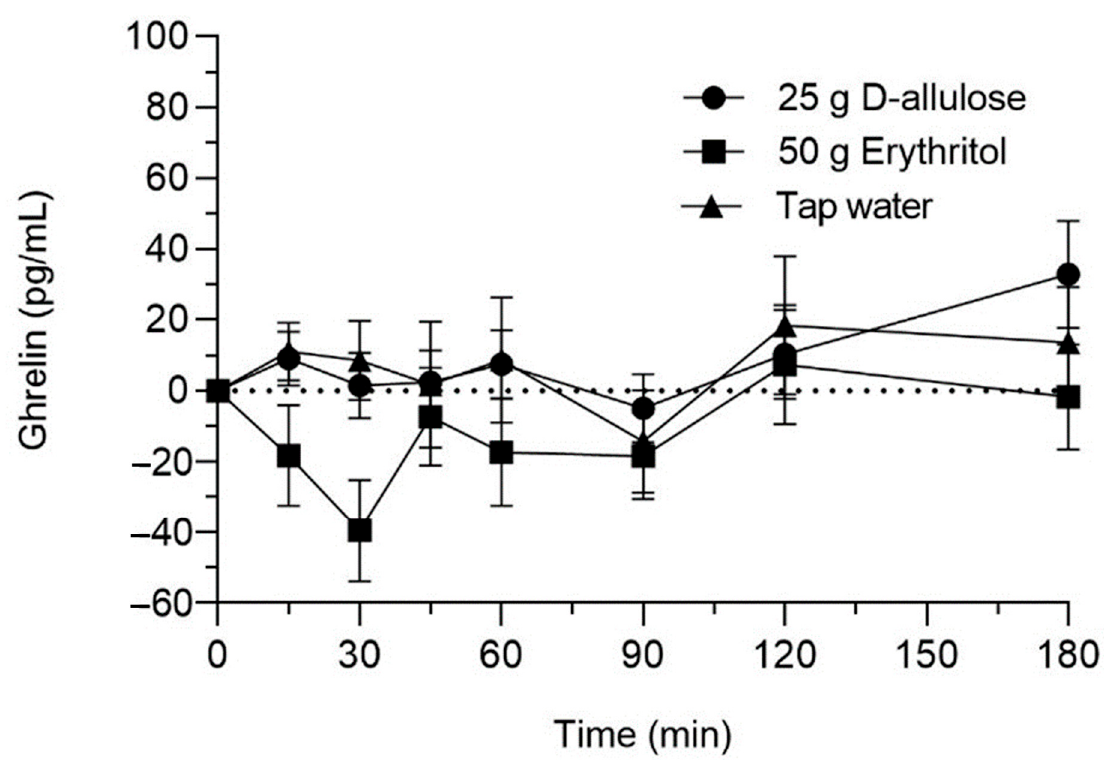
Figure 4. Ghrelin concentrations in response to intragastric administration of solutions containing 25 g D-allulose, 50 g erythritol or tap water to 18 healthy subjects. Data are expressed as mean ± SEM, and changes from baseline values are shown.